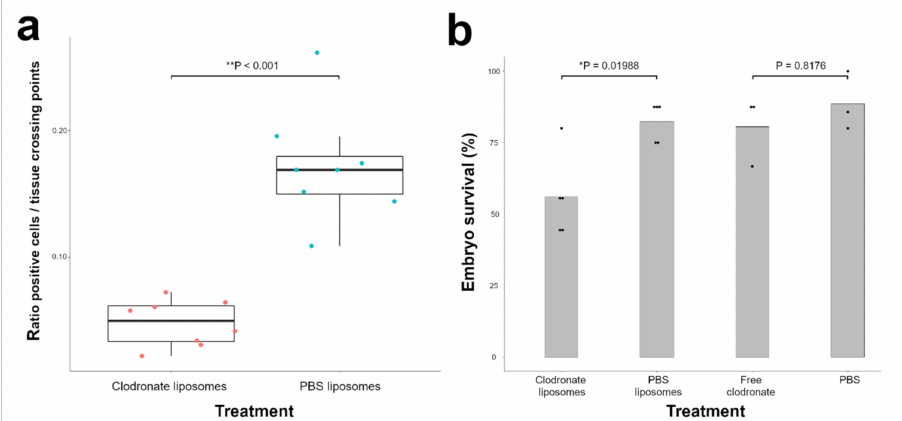
Figure 3. Chicken macrophages are significantly reduced 3 days after injection with clodronate liposomes in the chicken em- bryo. ( a ) Quantification of KUL01-positive cells by immunohistochemistry revealed a 3.4-fold decrease in KUL01-positive cells (** p < 0.001). The orange and blue dots represent the average ratio positive cells/tissue crossing points per individual sample of clodronate liposome and PBS liposome-treated embryos respectively. The Wilcoxon rank sum test was used to analyse statistical significance. Data are presented as boxplots showing the median, first and third quartiles. ( b ) Injection of clodronate liposomes but not free clodronate significantly reduces viability in the chicken embryo: 56% of clodronate liposome-injected embryos were alive 3 days after injection versus 82.5% of PBS liposome-injected embryos (* p = 0.01988). On the other hand, embryo viability after injection with free clodronate measured 80.56% versus 88.57% after PBS injection ( p = 0.8176). The black dots represent the embryo survival % per individual experiment. Statistical significance was determined with the Cochran–Mantel–Haenszel